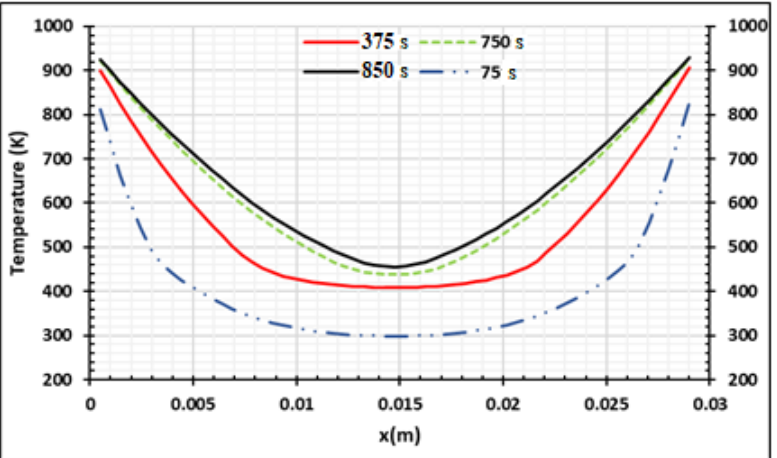
Figure 8. Wood temperature distribution at T f = 973.15 K using samples of 30 mm thickness at four process times, ρ bo = 700 kg/m 3 .